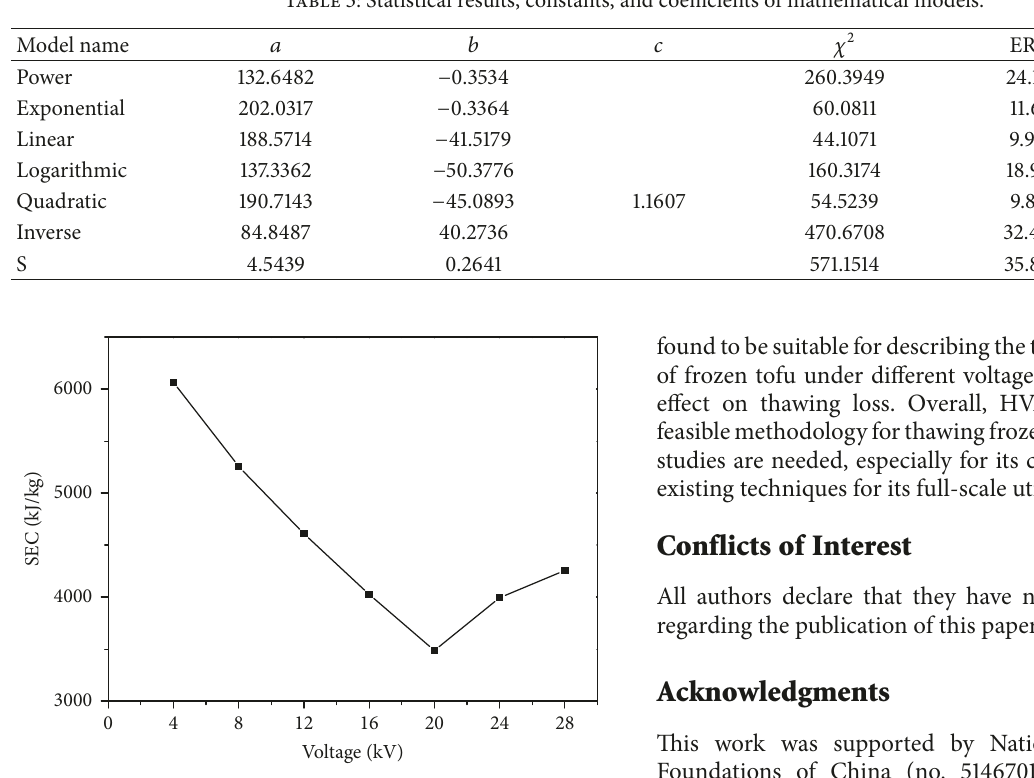
square error (ERMS), reduced mean square of the deviation ( 𝜒 2 ), and the modeling efficiency (EF) from mathematical models are given in Table 3. The results indicated that, in Exponential, Linear, and Quadratic models, the values of EF are above 0.96, and 𝜒 2 and RMSE values ranged from